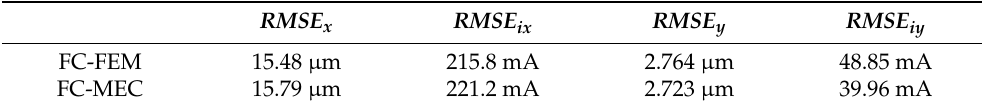
Table 3. RMSE values for a step change of the rotor along the x -axis RMSE x RMSE ix